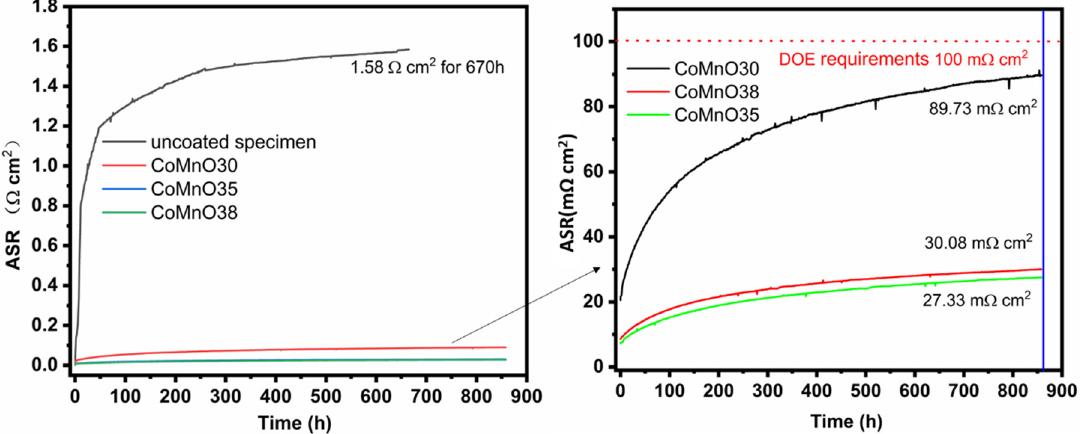
Figure 9. ASR values for bare steel and covered samples (CoMnO30, CoMnO35, CoMnO38) as function with time.